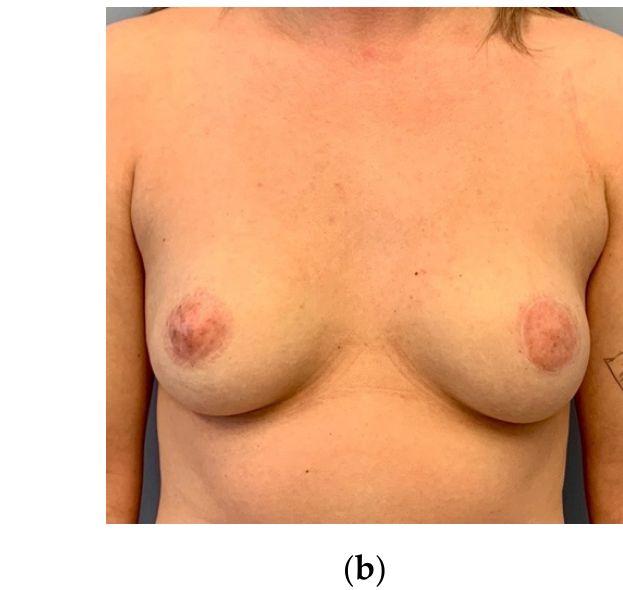
( b ) Figure 6. ( a ) Preoperative: 37-year-old patient with triple negative invasive breast cancer right, re- ceiving neoadjuvant chemotherapy. No genetic mutation was detected. The patient desired a bilat- eral mastectomy. ( b ) Three months after bilateral circumareolar mastectomy and reconstruction with inner thigh flaps and free NAC grafts. No other scars evident at the breasts apart from the circumareolar. The nevus left was also excised. ( a ) ( b ) Figure 7. ( a ) Preoperative: 28-year-old patient with BRCA 1 mutation asking for risk-reducing mas- tectomy. Right side larger and more ptotic than left side. Sternal notch-to-nipple distance and nip-